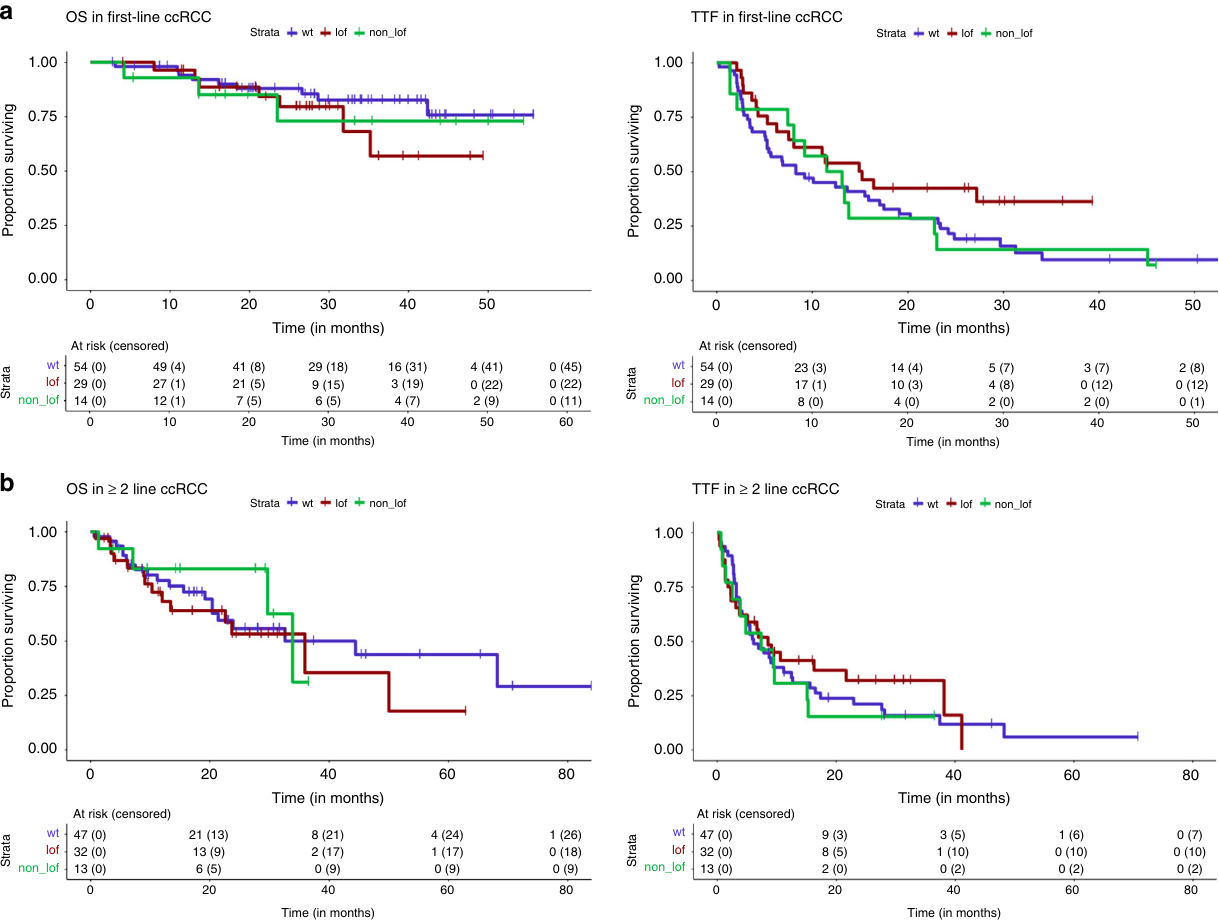
Fig. 5 Survival and time to treatment failure in PBRM1 mutated MSKCC ccRCC patients by line of therapy. Overall survival (OS) and time-to-treatment failure (TTF) in MSK-IMPACT ccRCC ( n = 173) strati fi ed by a fi rst line and b ≥ second line of treatment (line of treatment not available in 12/185 patients).